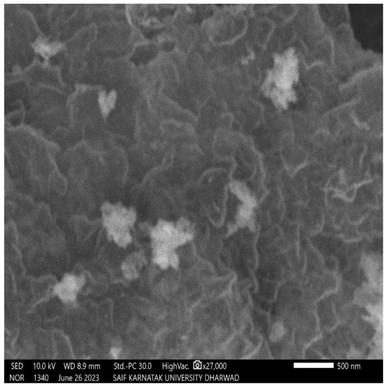
SEM Micrographs of ZnFe(2-x)LuxO4, where x = 0.01(Lu 0.01), 0.03(Lu 0.03), 0.05(Lu 0.05), 0.07(Lu 0.07).